Question: Provide a one-line summary of what is displayed.
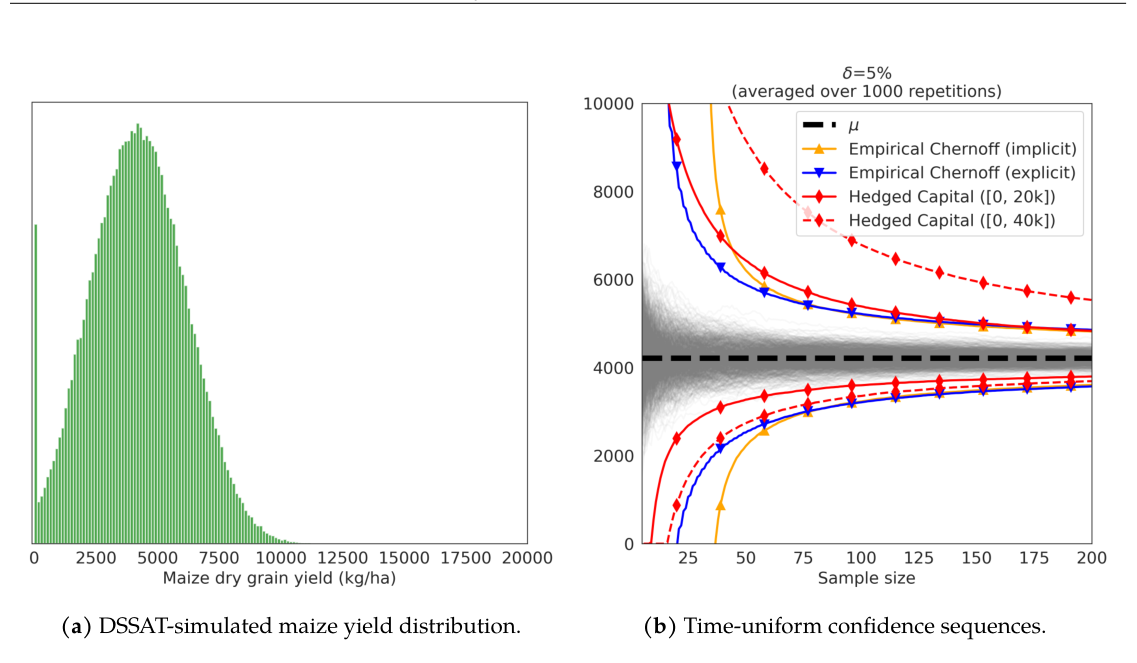
Answer: 1 – Comparison of median fixed sample confidence bounds around the mean for a Beta (50, 50) distribution, as a function of the sample size t, over 1000 independent replicates. Grey lines are trajectories of empirical means bµt.